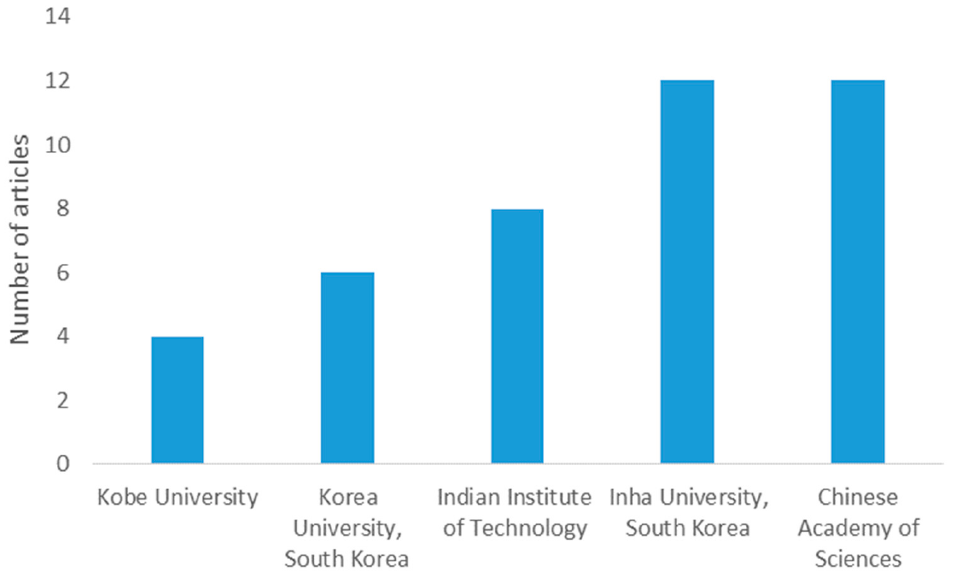
Figure 5. The most productive institutes/universities (min. 4).